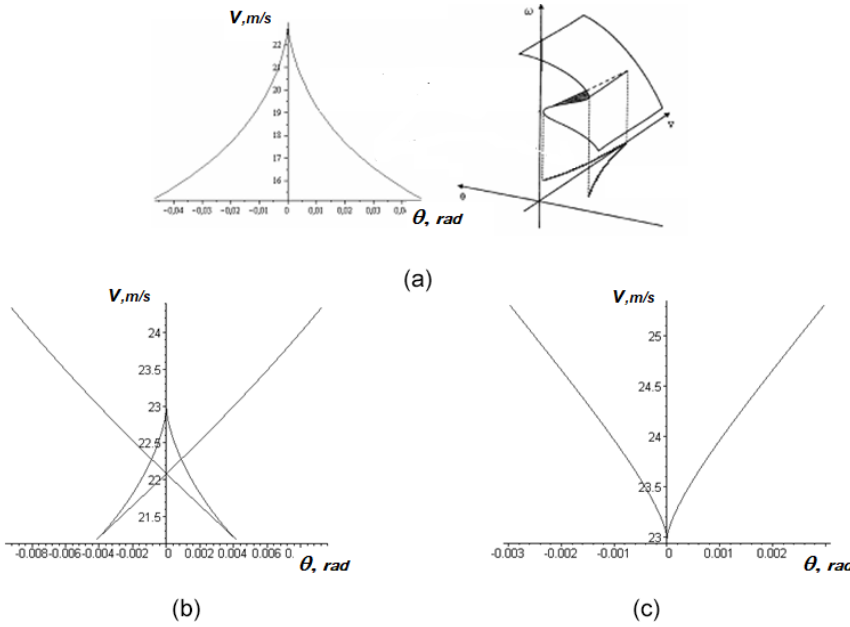
Figure 2. Changes in the bifurcation manifold as ϕ 1 decreases.